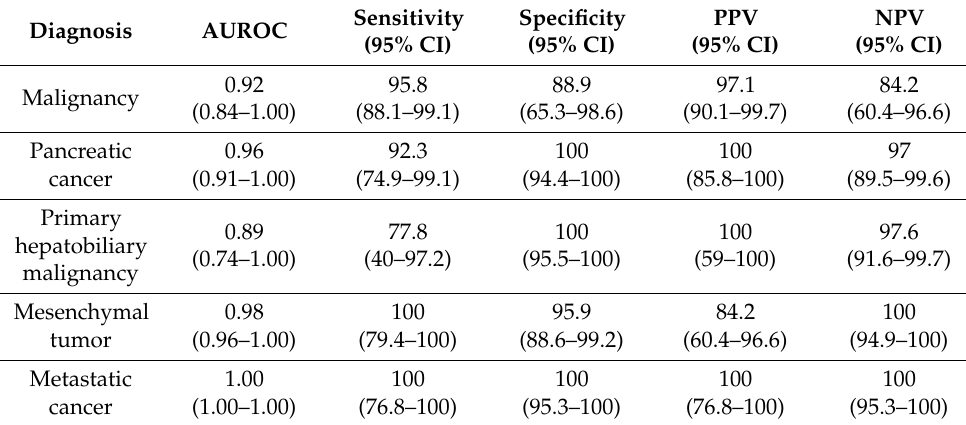
Table 5. Diagnostic performance of EUS-FNB for solid